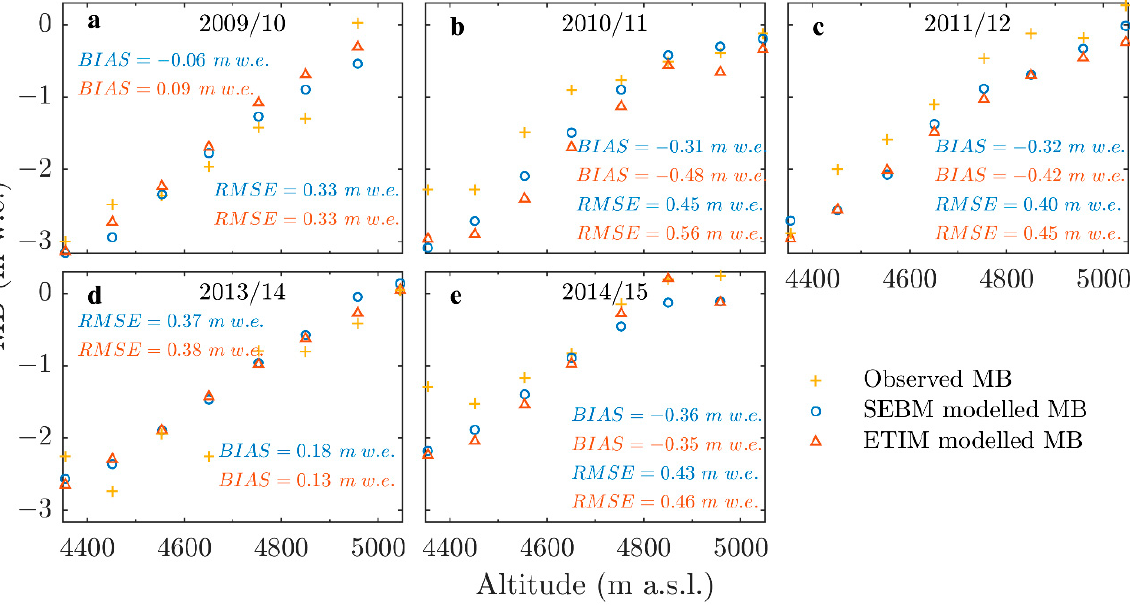
Figure 4. Observed and modeled mass balance (MB) at different altitudes from 2009/10 to 2014/15 (a-e, excluding 2012/13). Blue and red symbols represent SEBM and ETIM, respectively.